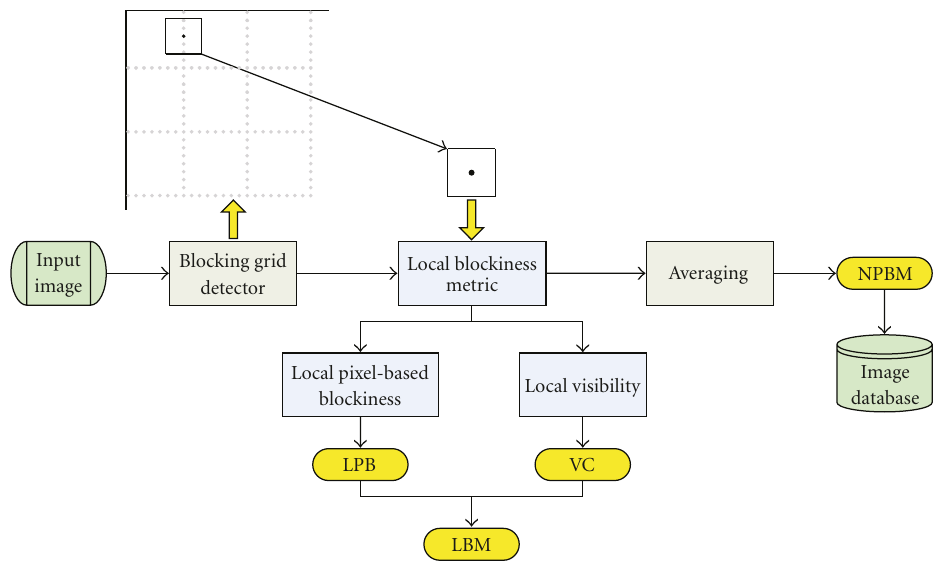
Figure 1: Schematic overview of the proposed